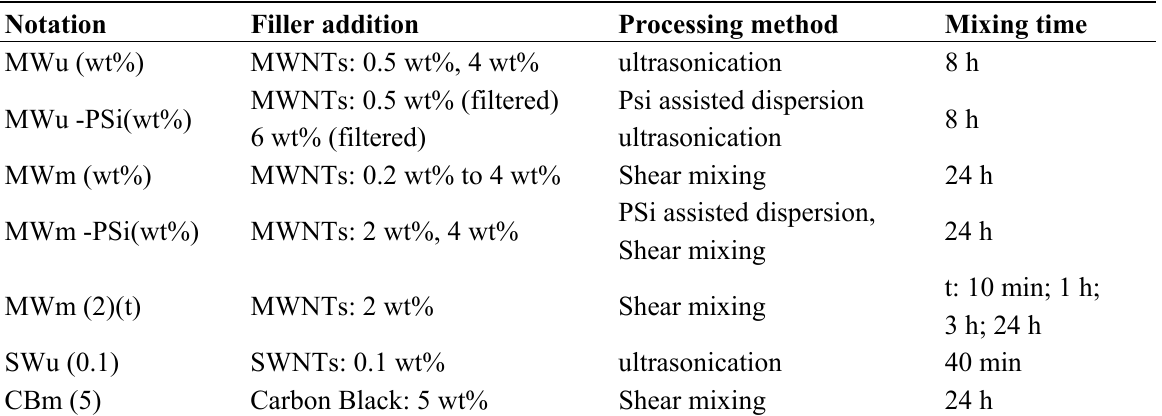
Table 2. Listing the fabrication conditions represented by each sample label in Figure